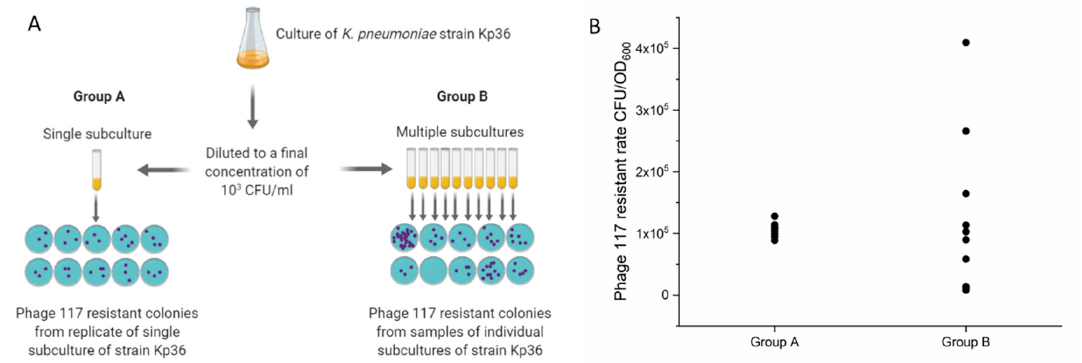
Figure 6. ( A ) Flow chart and schematic of the fluctuation experiment set-up. This figure was generated with the help from Biorender (https: // biorender.com / ). ( B ) The relative number of Phage 117 resistant colonies varies dramatically in group B, while the variation in group A is relatively small, indicating that phage 117-resistant mutants were likely aroused before phage infection.